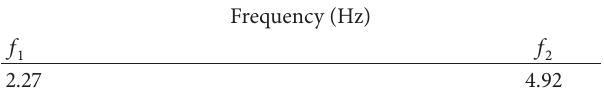
Table 4: Frequency values of mathematical